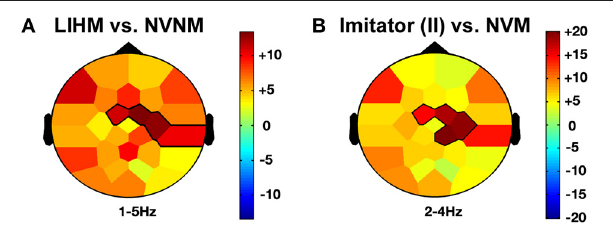
FIGURE 4 | Other agency and delta frequency band effects. LIHM versus NVNM (A) and Imitator in II versus NVM (B) show a similar increase of delta activity ( > 0–5Hz) mostly over the right central region. The color stands for the mean t -values across the frequency range of the considered clusters. Statistical clusters are outlined in thick black lines for both representations. For abbreviations, see previous figures. LIHM, library of intransitive hand